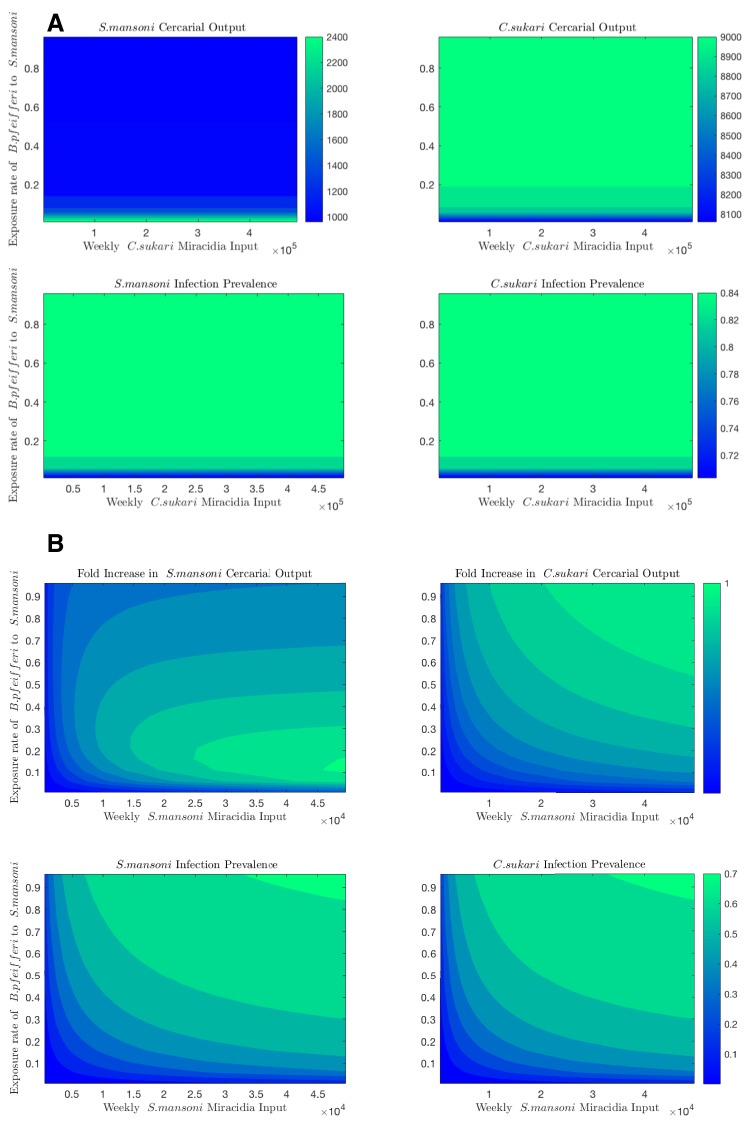
The infection prevalence of S. mansoni and C. sukari in B. pfeifferi and their cercarial production are sensitive to both the exposure rate per week per snail density in the habitat and the weekly input of S. mansoni miracidia (3a), but less sensitive to the weekly input of C. sukari miracidia (3b).